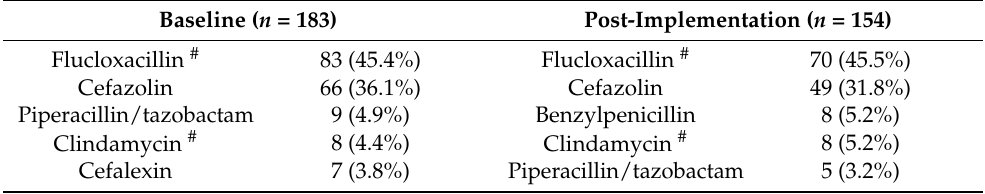
Table 3. Most common antibiotics prescribed on day 1 of inpatient antibiotic